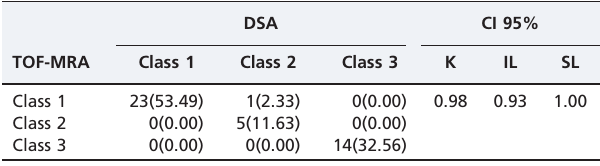
Table 1 - Aneurysm occlusion status as assessed by DSA and TOF-MRA, with Raymond’s classification, after interobserver consensus.